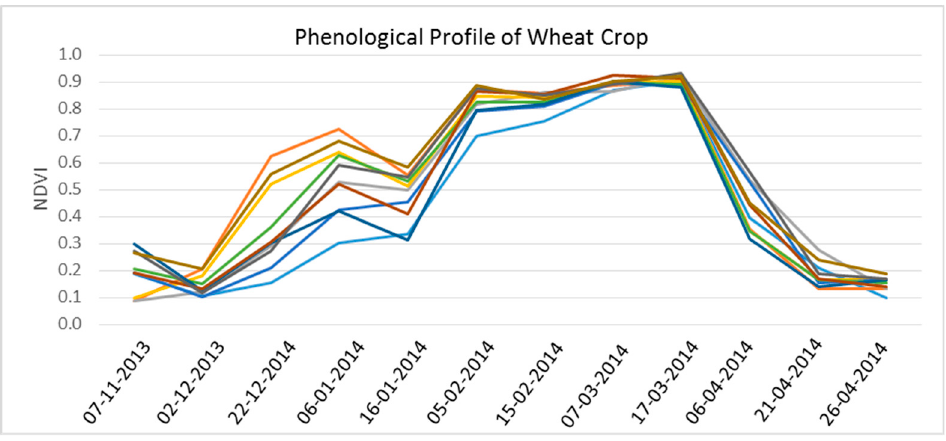
Figure 5. Phonological profile of wheat crop.